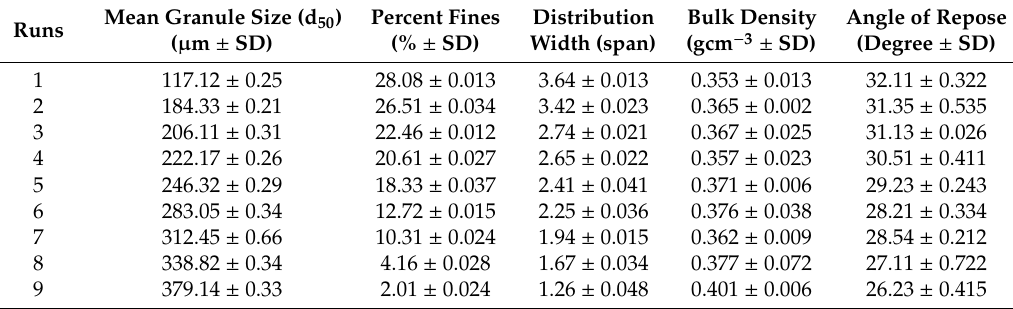
Table 2. Physical properties of prepared granules (mean ± SD).